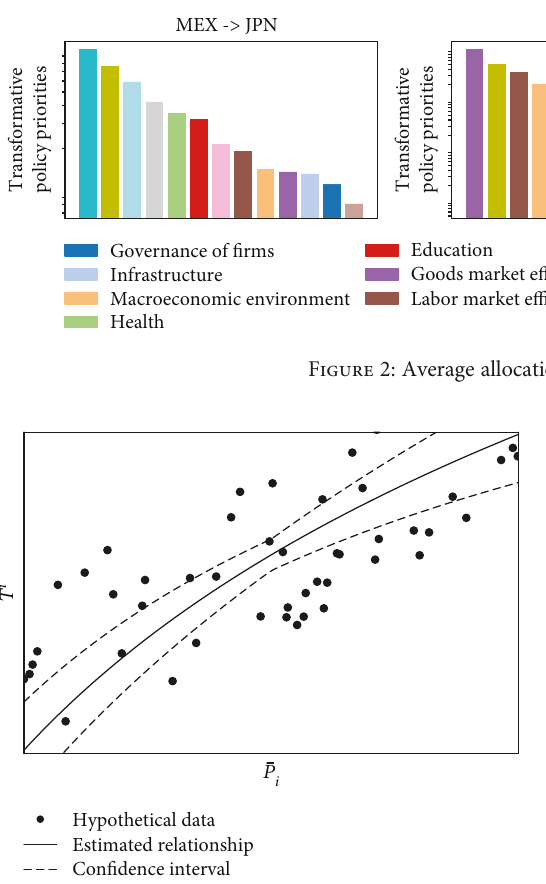
Figure 3: Hypothetical identi fi cation of resilient/fragile